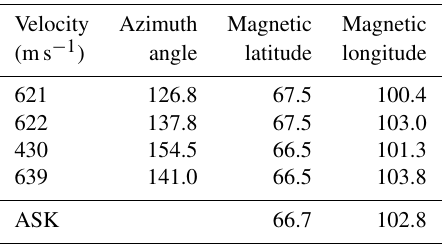
Table 1. Merged velocities from the Hankasalmi and Pykkvibaer radars between 21:24 and 21:26UT on 9 November 2006 with co- ordinates, including those of ASK at